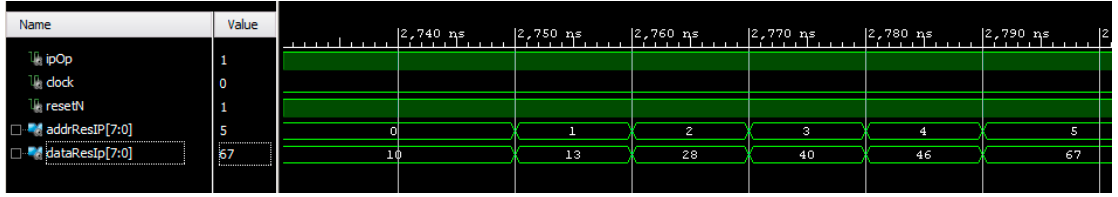
Figure 10. Simulation study results: Inner product.